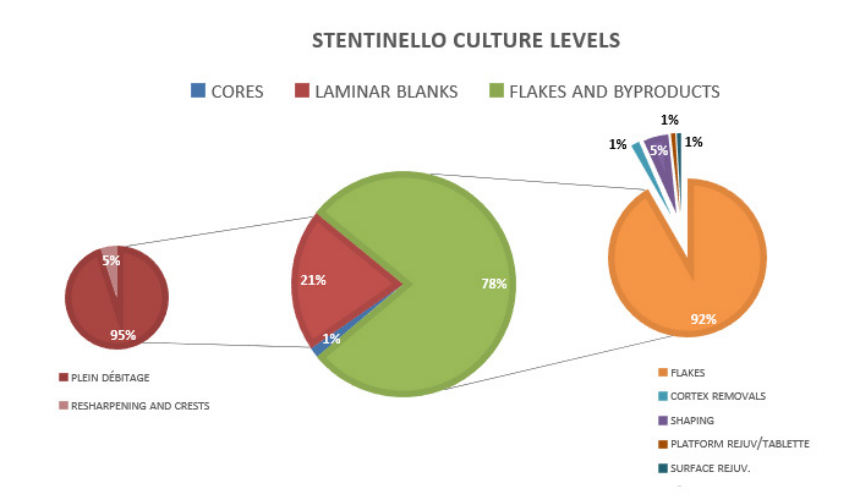
Figure 8. S. Martino. Distribution of the obsidian knapping products from Stentinello occupation